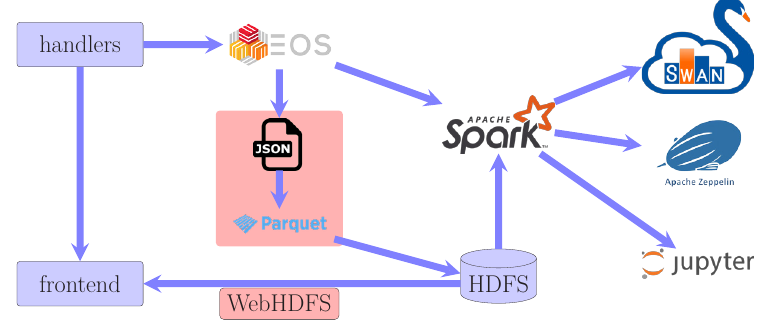
Figure 2. Integration of LHCbPR with Hadoop